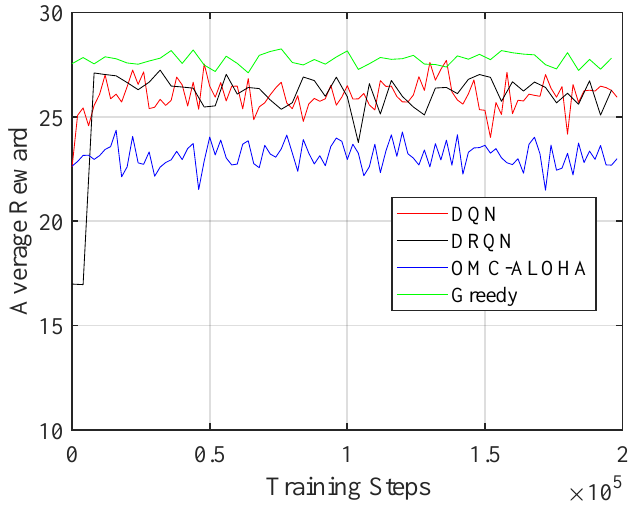
Figure 6. The average reward of the proposed method with different training steps (single SU).